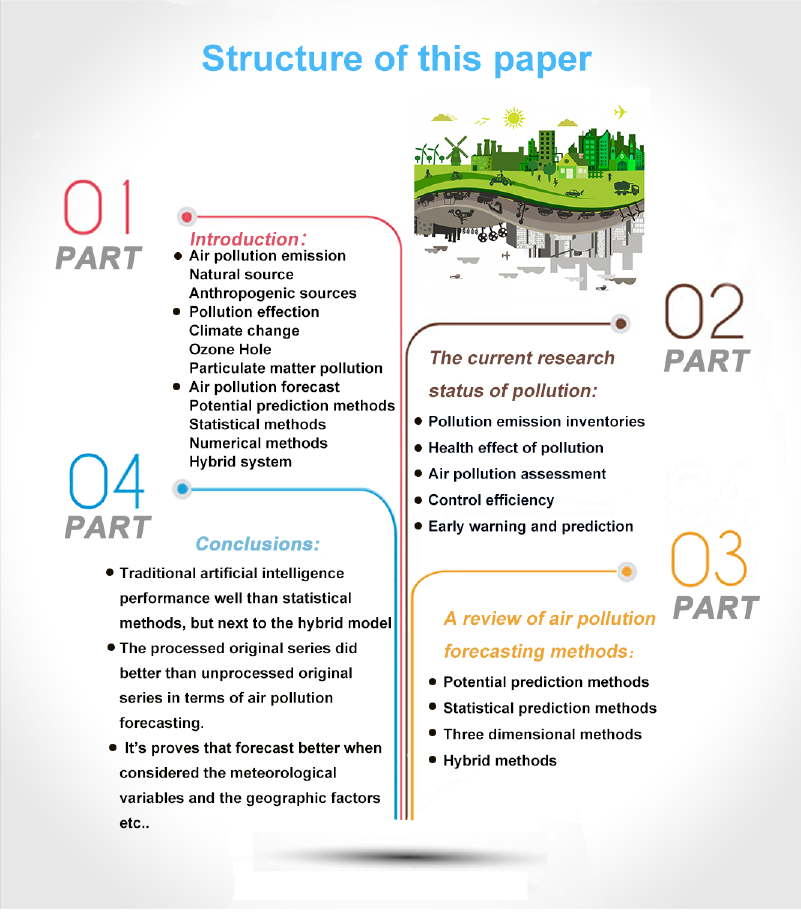
Figure 1. The construction of this paper.